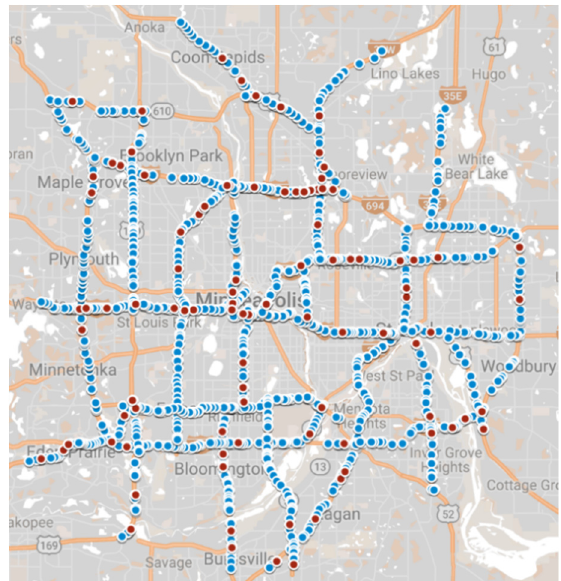
Figure 3. Case study area—complete data set ( blue circles ) and research sample ( red circles ).